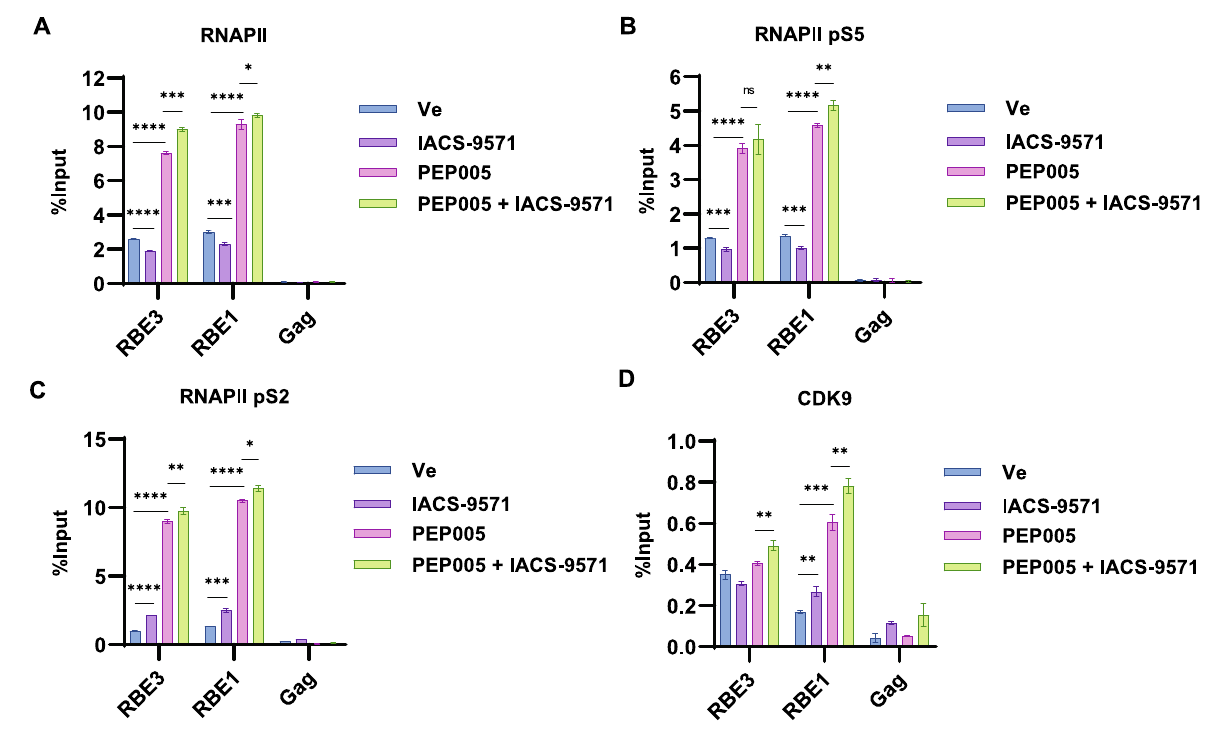
Figure 8. IACS-9571 stimulates association of transcriptional elongation factors with the HIV-1 LTR. ( A – D ) Jurkat mHIV-Luciferase cells were treated with 10 µM IACS-9571, 20 nM PEP005, 10 µM IACS-9571 and 20 nM PEP005, or DMSO (Ve). 4 h post-treatment ChIP was performed using the indicated antibody. Displayed are the average of replicate qPCR determinations with error bars representing standard